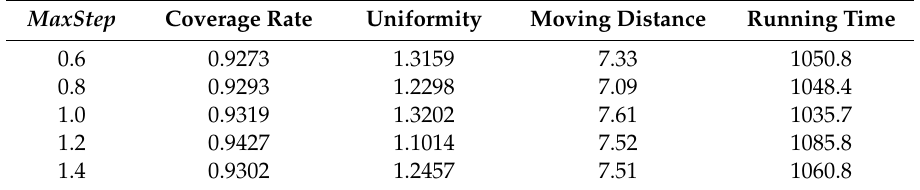
Table 2. Comparison of four indicators of the VFLGWO algorithm with di ff erent MaxStep values.